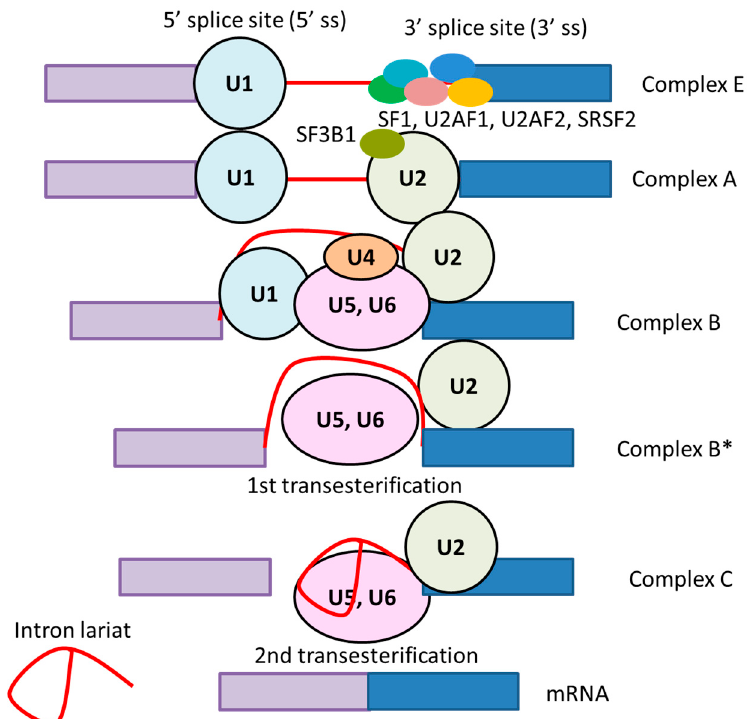
Figure 2. RNA splicing machinery that involves several distinct complexes. The first complex is formed by binding of U1snRNP and U2AF1/2 to the transcribed pre-mRNA. Establishment of complex E activates the recruitment of U2snRNP and forms complex A. The U4/U6.U5 tri-snRNP complex joins and leads to the formation of complex B. After release of U1/U4 snRNPs, complex B is catalytically activated (complex B*), followed by the next conformational change that results in the formation of complex C. Complex C subsequently catalyzes the second esterification reaction and excises the intron as intron lariat. snRNP: small nuclear ribonucleoprotein. U2AF: U2 small nuclear RNA auxiliary factor.